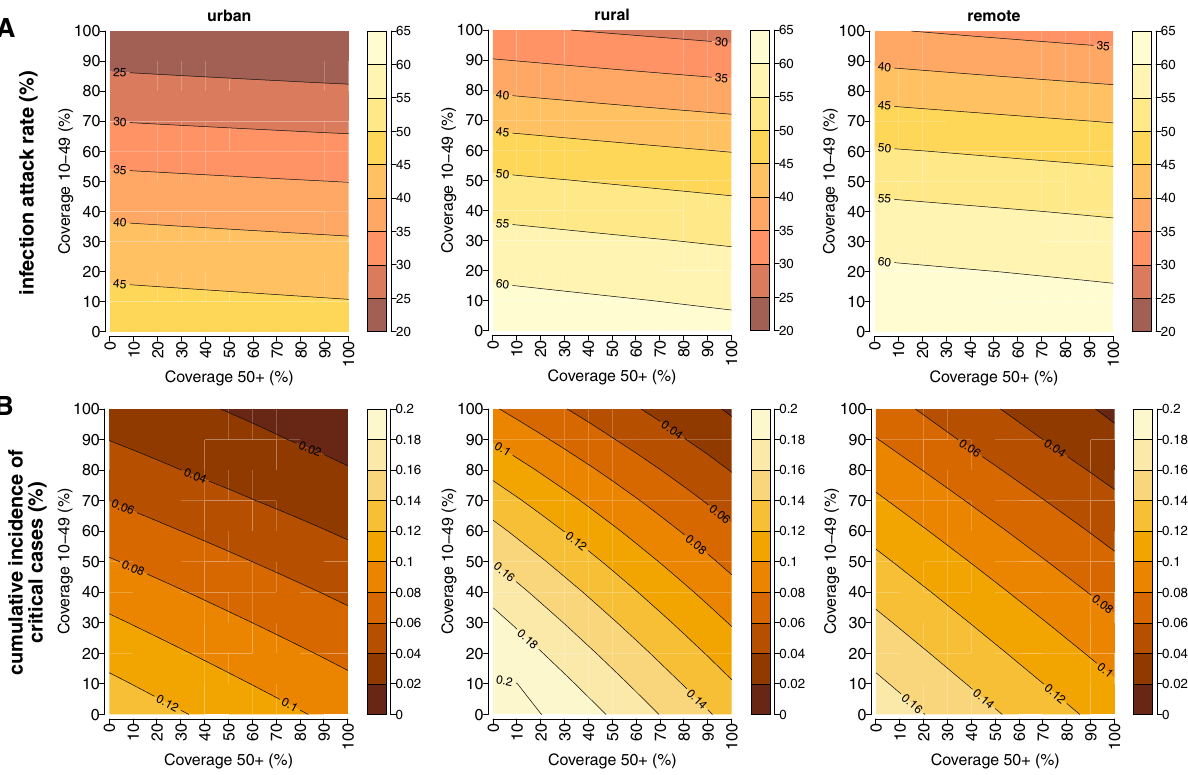
Figure 5. Infection attack rate ( A ) and cumulative incidence of critical cases ( B ) as estimated for urban, rural, and remote areas for different combinations of vaccination coverage in individuals aged 50 years or more and in individuals aged 10-49